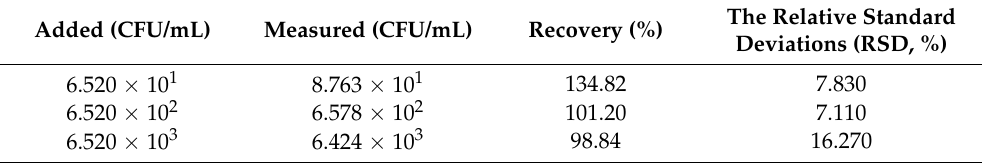
Table 1. Electrochemical biosensor based on locked nucleic acid for the detection of Penaeus vannamei .